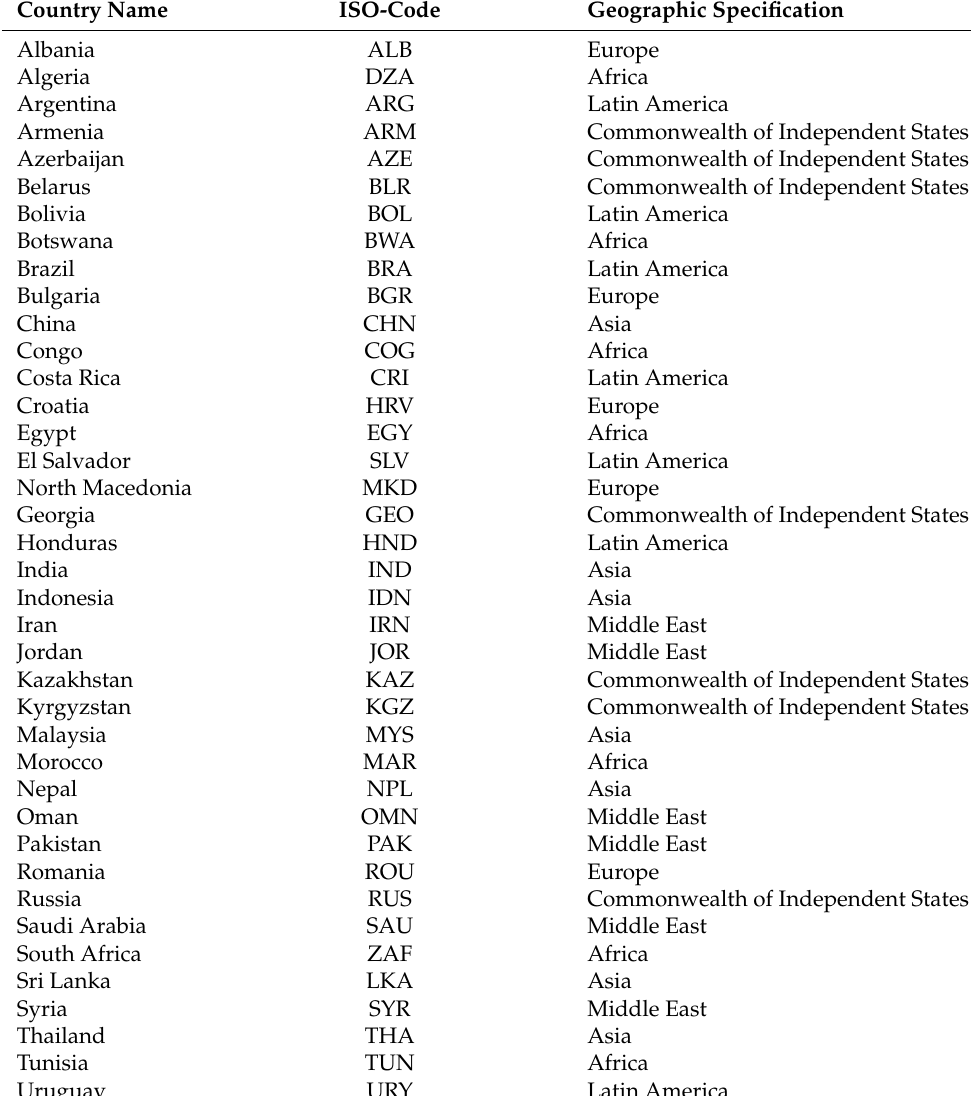
Table 2. Panel of 39 developing countries used in the analysis.